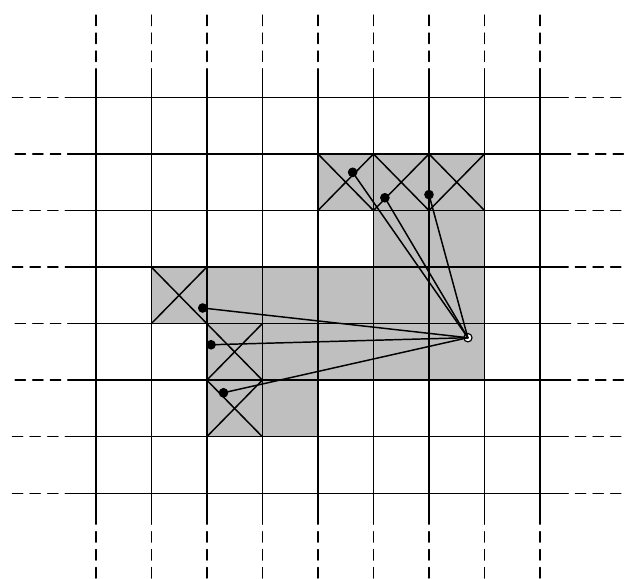
Figure 1. The relationship between the scanning point and the grid points.